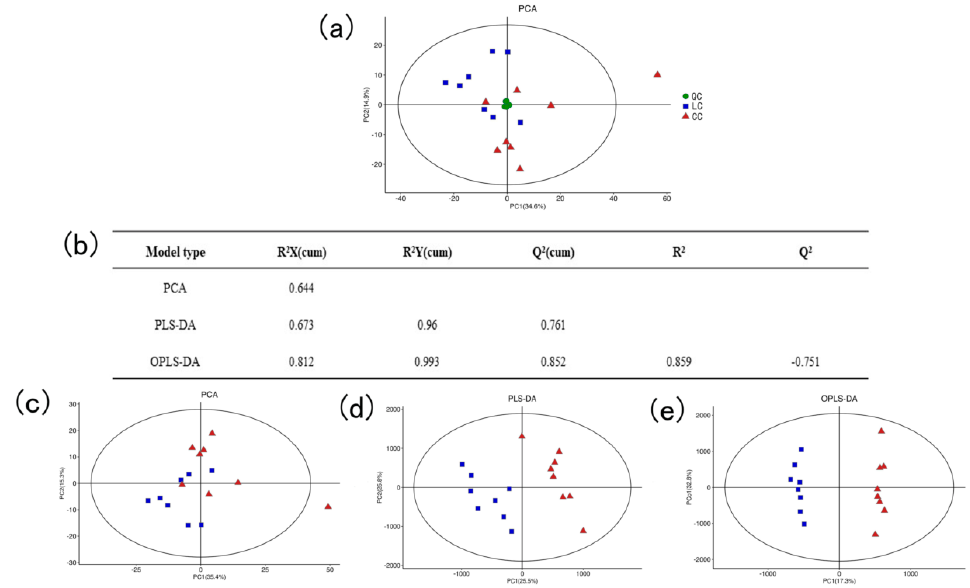
Figure 2. Multivariate statistical analysis. ( a ) PCA score plot for the data from QC samples and all groups. ( b ) The parameter of the statistical model. ( c ) PCA score plot for the data in the LC group and CC group. ( d ) PLS-DA score plot for the data in the LC group and CC group. ( e ) OPLE-DA score plot for the data in the LC group and CC